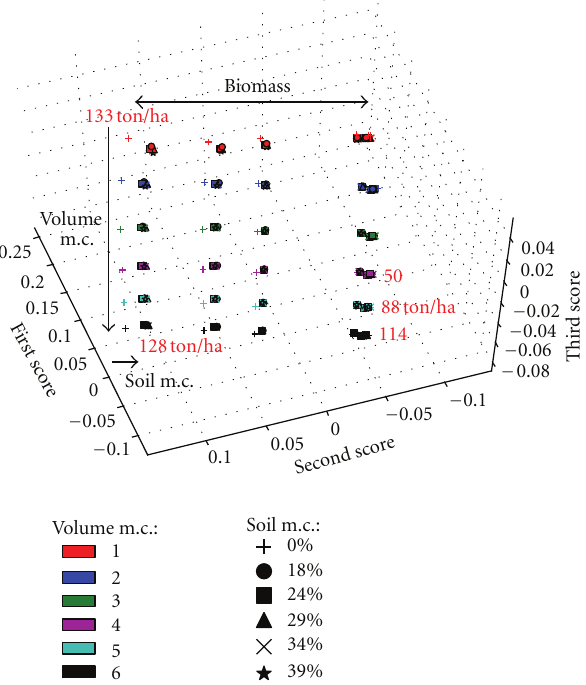
Figure 11: Result of a PCA on radar HH, HV, VV radiometry and optical NINSOL index for forest without leaves. Figure 12: Result of a PCA on optical NDVI, GVMI, and NINSOL indexes for forests with needles.